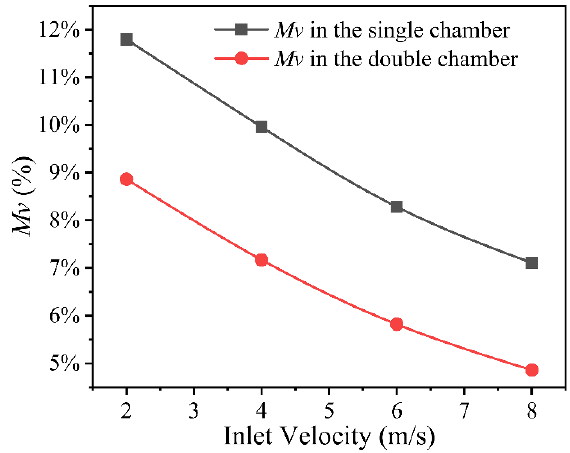
Figure 8. Gas outlet velocity unevenness coefficient.